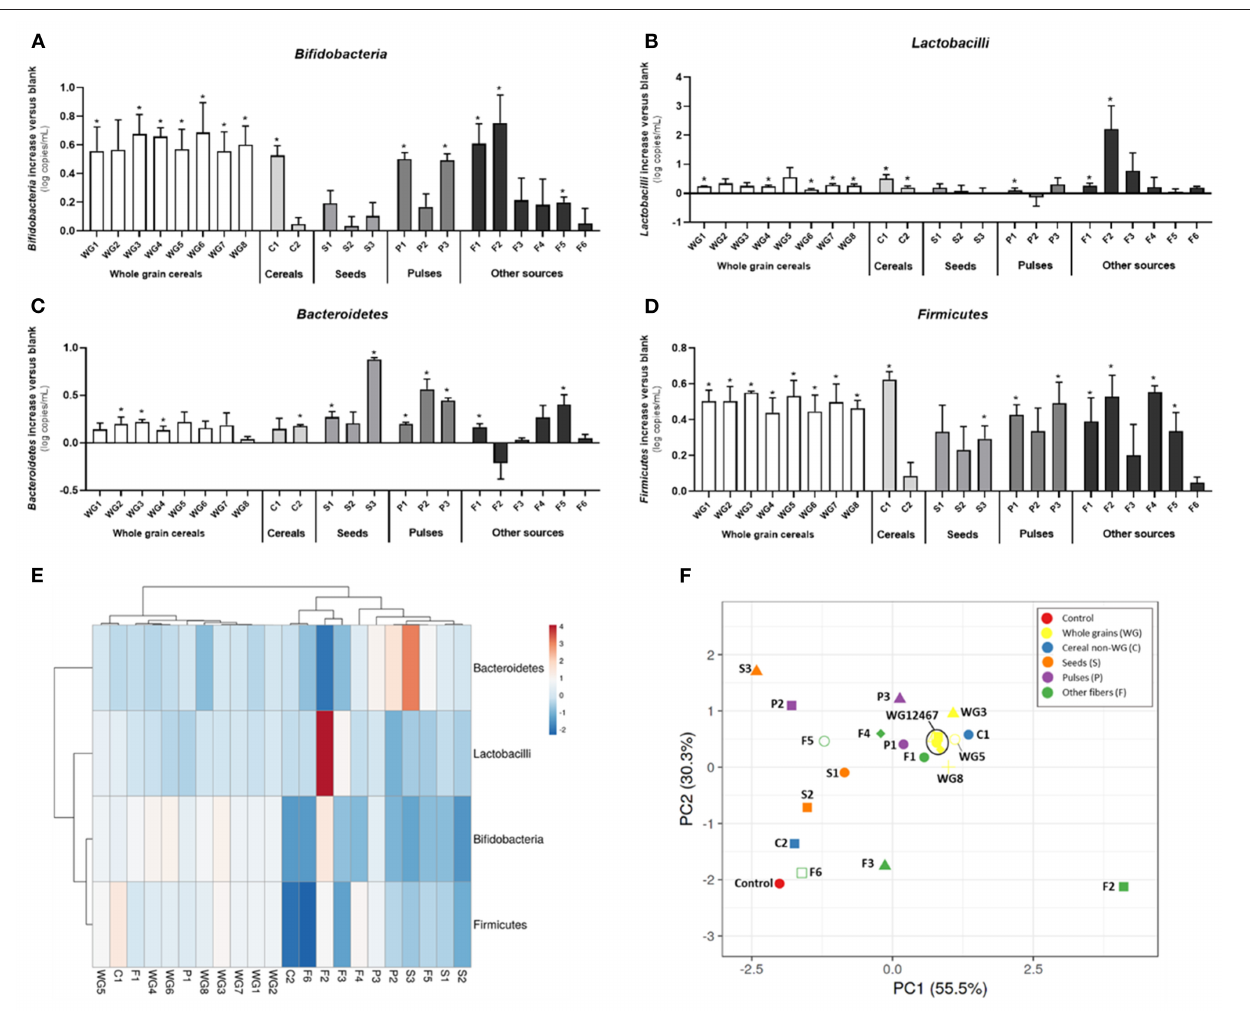
Frontiers in Nutrition |